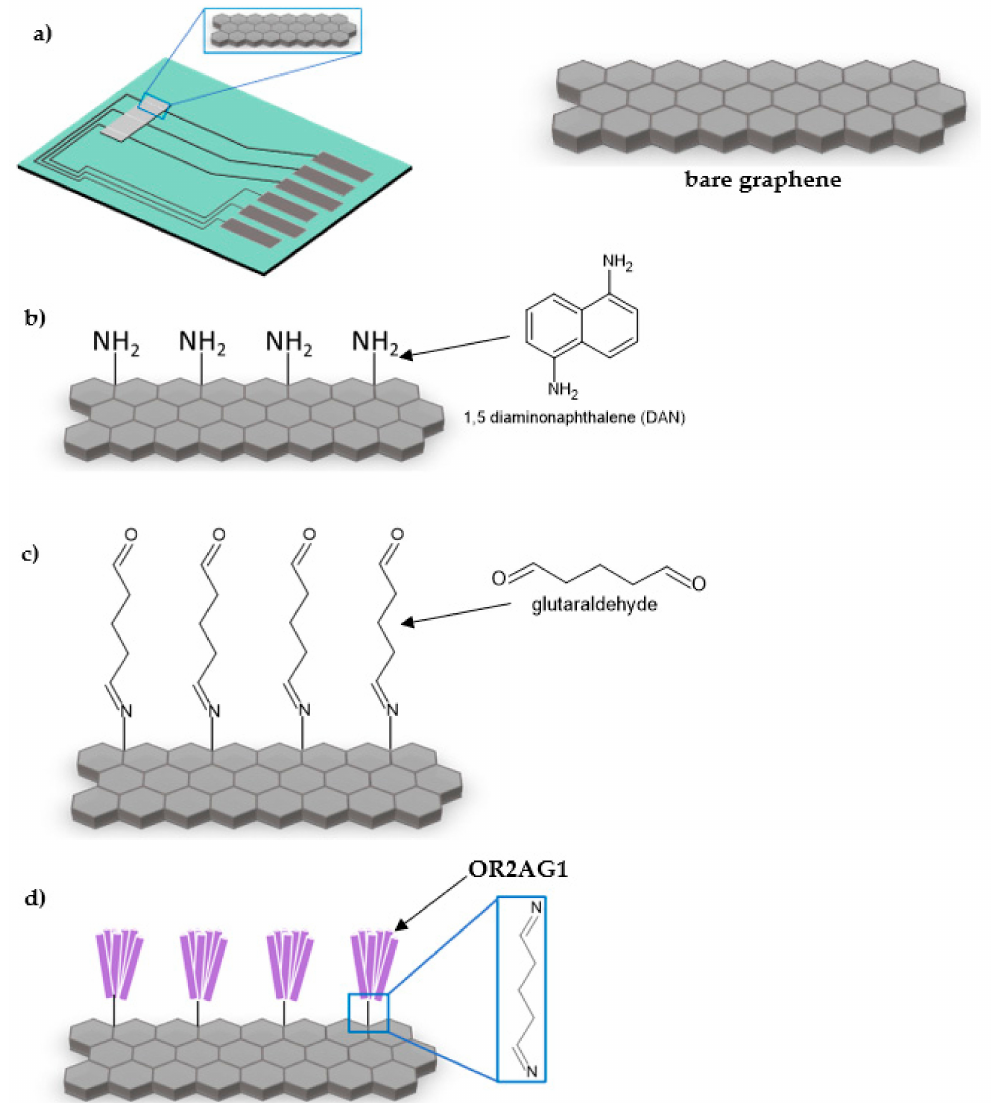
Figure 1. Functionalization of graphene: ( a ) schematic of graphene resistor chip (18,200 µ m × 9700 µ m), ( b ) 1,5 diaminonaphthalene chemical modification of the bare graphene surface, ( c ) addition of glutaraldehyde, ( d ) immobilization of olfactory receptor